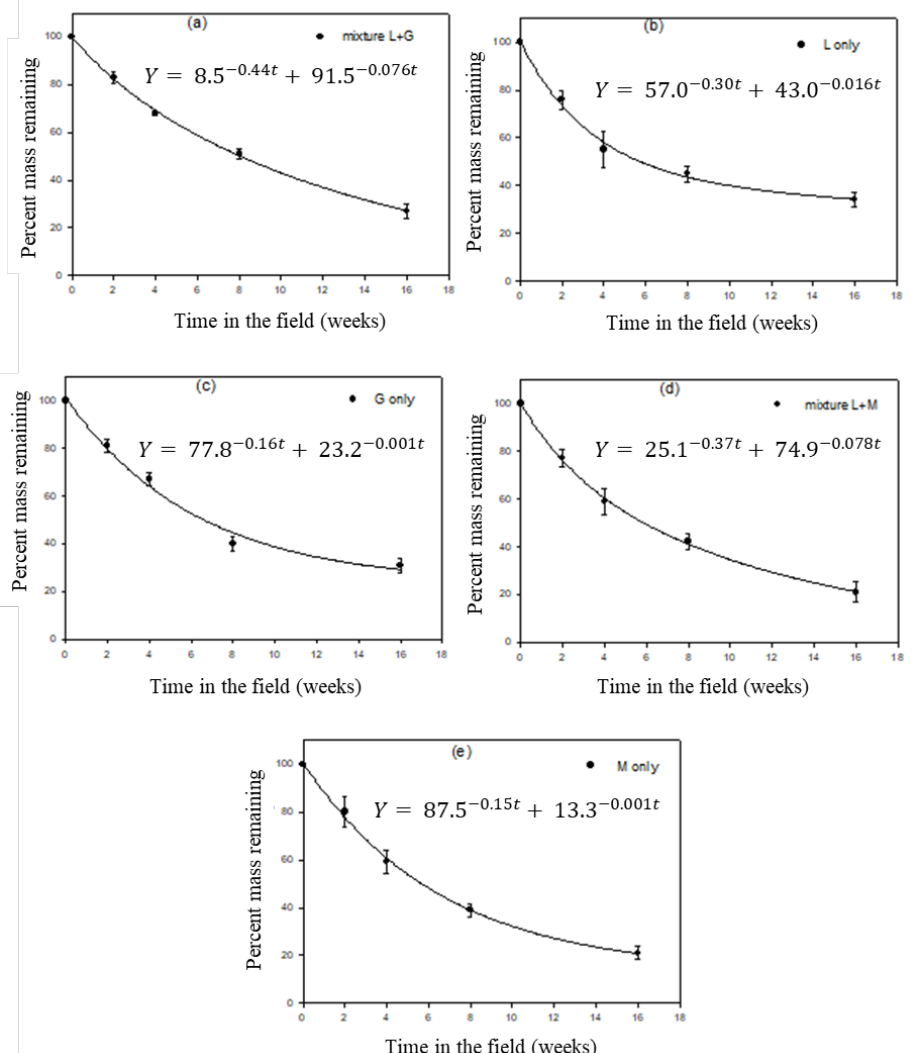
Figure 4. Modelled and measured mass remaining from decomposing leaves (( a ) = Leucaena + Guazuma , ( b ) = Leucaena , ( c ) = Guazuma , ( d ) = Leucaena + Moringa , ( e ) = Moringa ) for the dry period. Bars are SE.